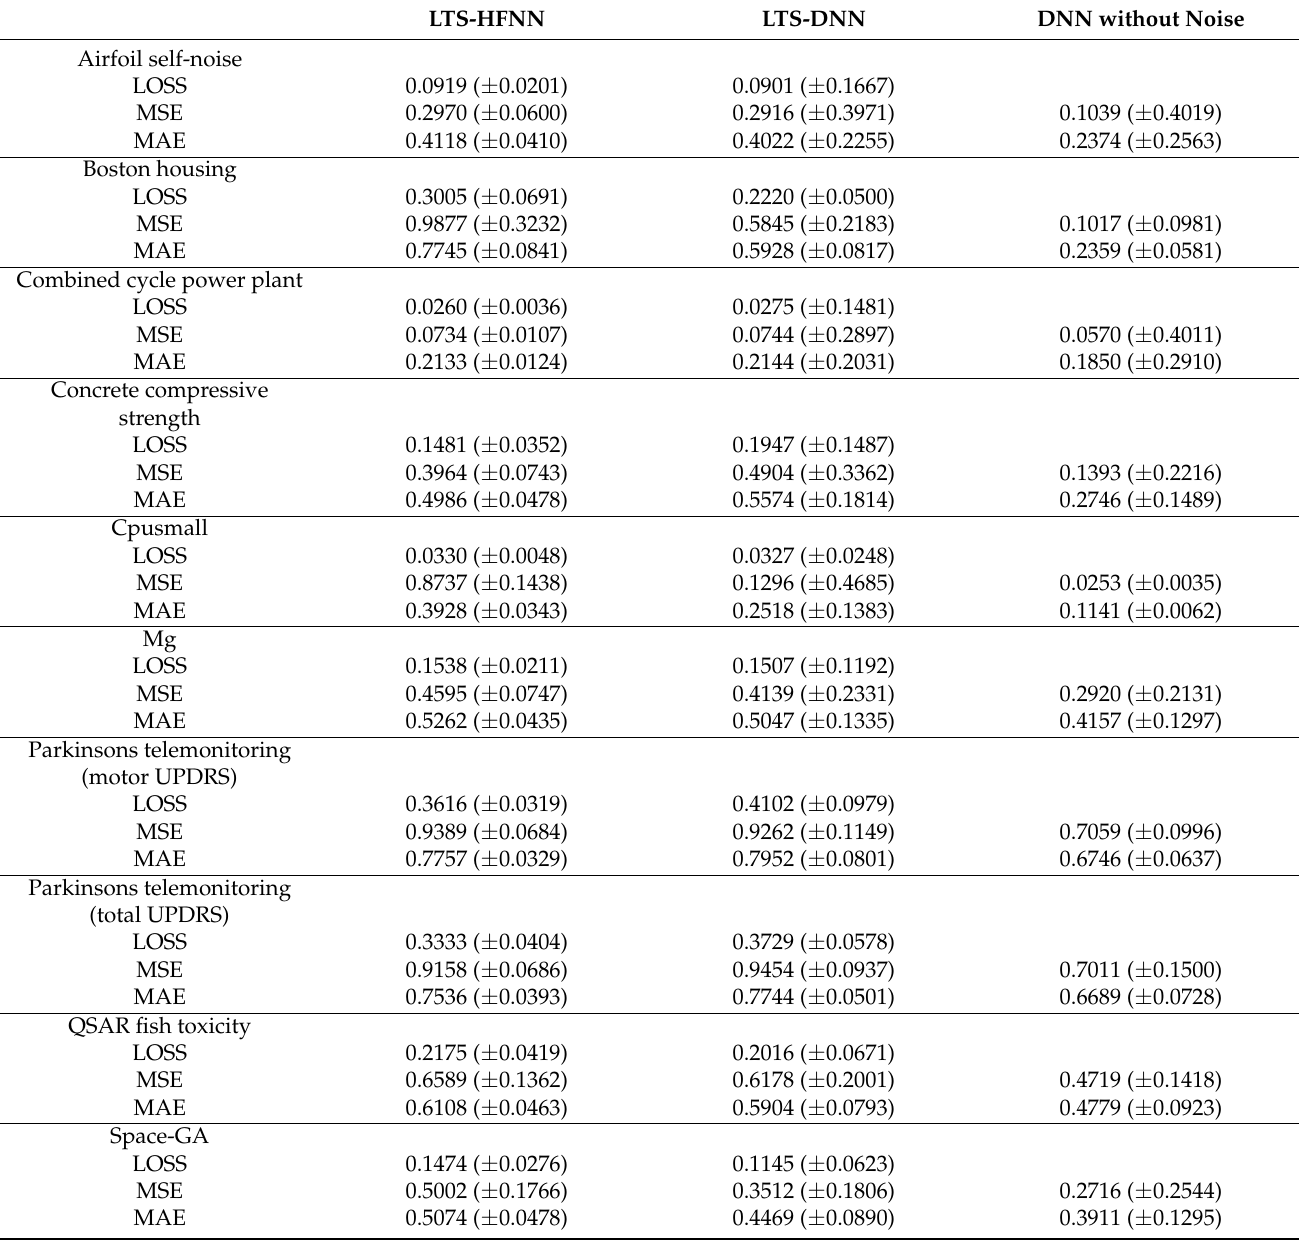
Table 3. Simulation results in Example